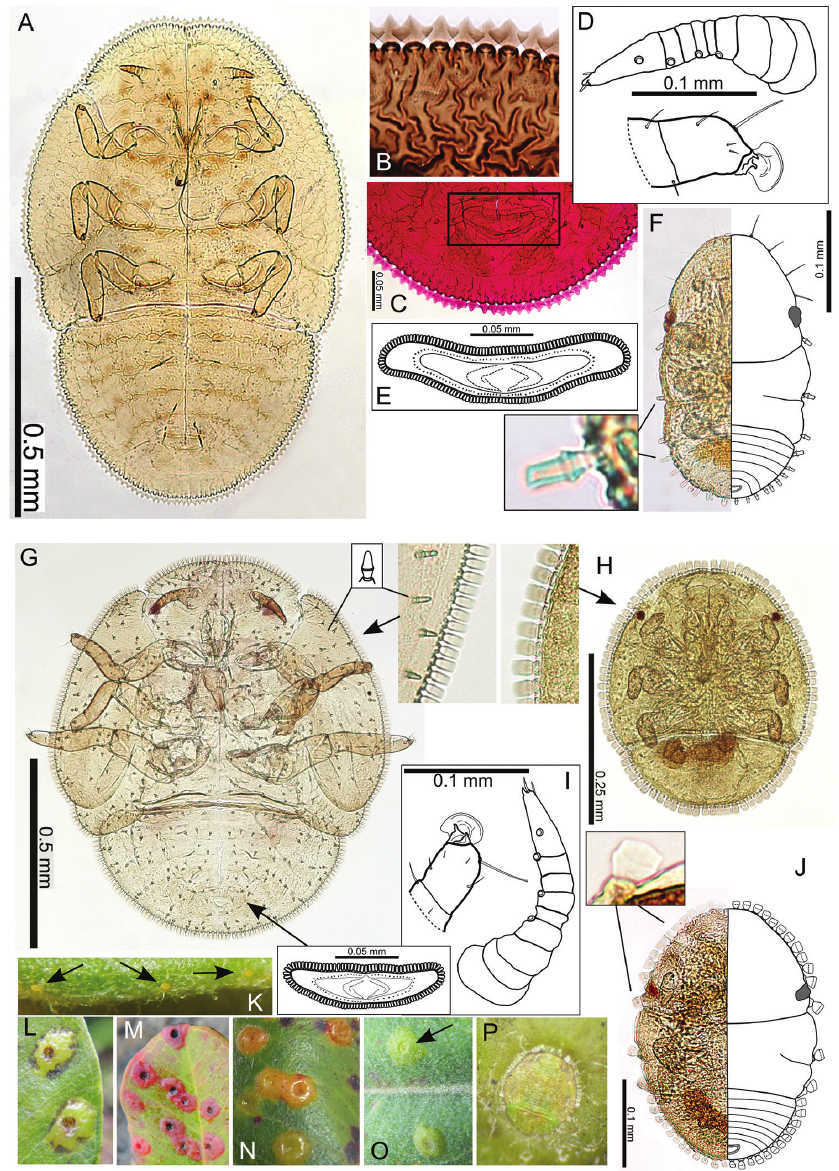
Figure 46. Pariaconus gracilis and Pariaconus minutus immatures. A–F P. gracilis : A 4 th instar B detail of marginal setae (5 th instar) C 4 th instar abdomen indicating position of anal ring (stained) D antenna and tarsi E anal ring (5 th instar) F 1 st instar with detail of marginal sectasetae (inset) G–P P. minutus : G 5 th instar with anal ring detail (inset below) and marginal and dorsal sectasetae detail (inset right) (form minutus ) H 2 nd instar with marginal sectasetae detail (inset) I tarsi and antenna J 1 st instar with detail of fan-shaped sectasetae (inset) K eggs scattered on upper leaf margin L, M, N raised gall tissue around empty pits on upper leaf surface: L pale coloured M red coloured N orange coloured O immatures inside pits on upper leaf surface P detail of immature seated in